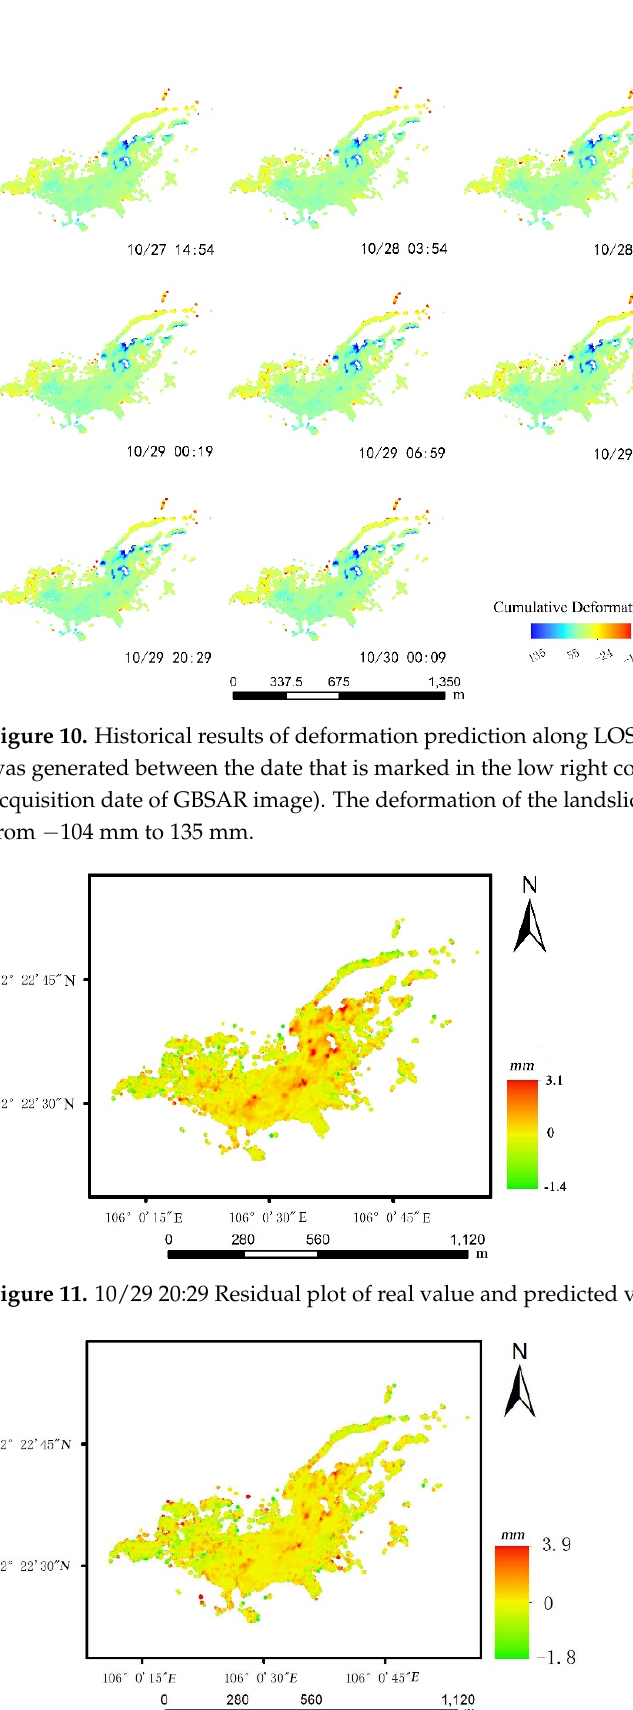
Figure 13. 10/30 00:09 Residual plot of real and predicted values.